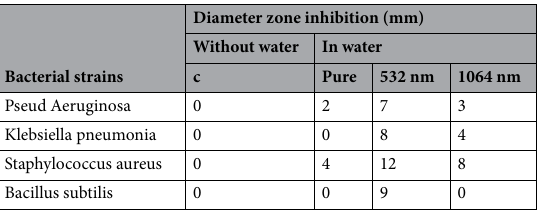
Bacterial strains